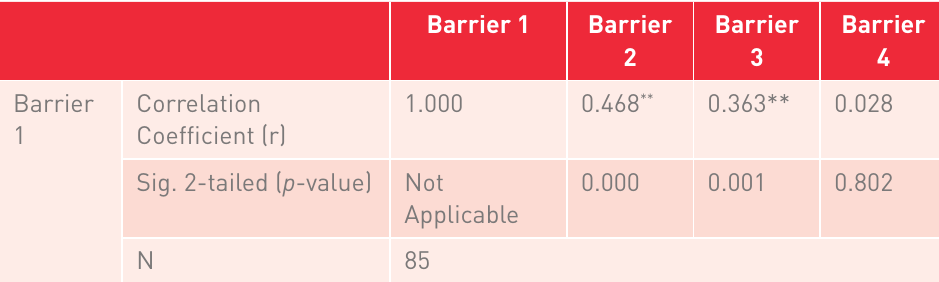
Sample analysis of Spearman’s correlation